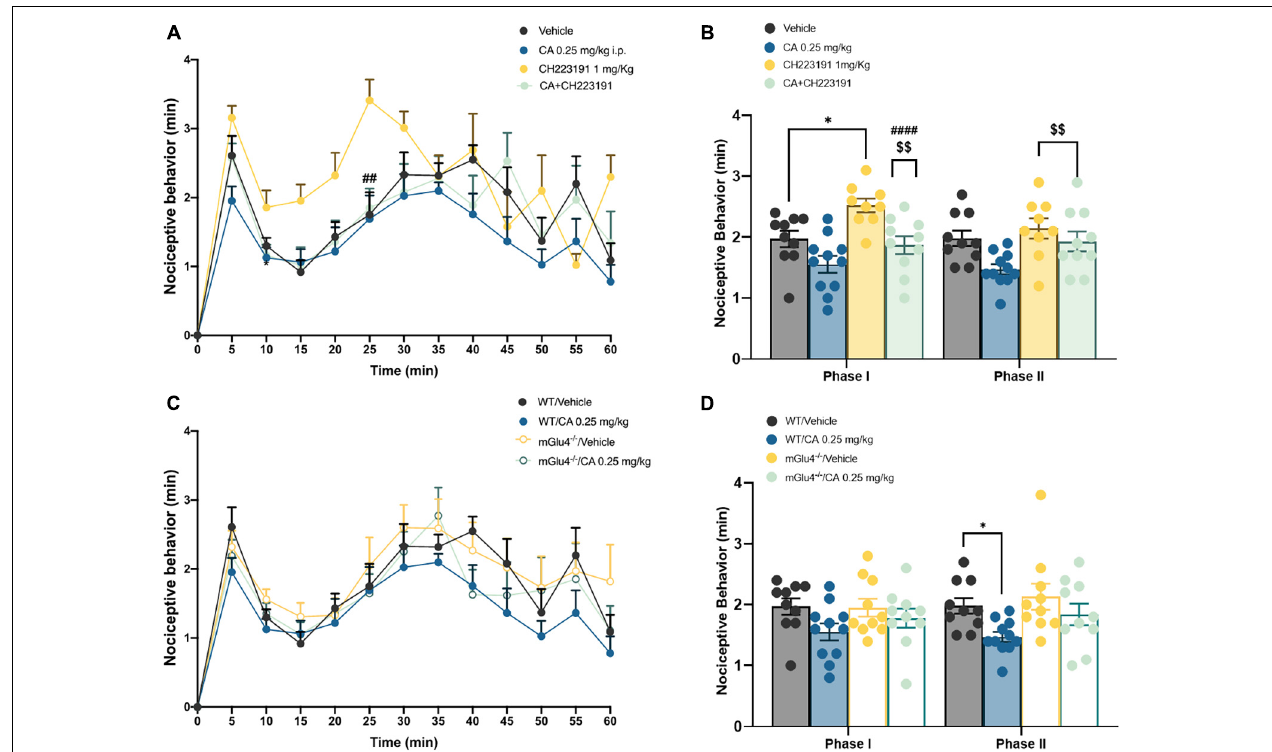
FIGURE 2 | Cinnabarinic acid-induced analgesia was mediated by the activation of mGlu4 receptor in WT and mGlu4 − / − mice. (A) Effect of cinnabarinic acid (0.25 mg/Kg) alone or in combination with CH223191 (1 mg/Kg) on formalin-induced pain behaviours, including lifting, flinching, and licking, observed for 60 min at 5 min intervals. (B) Total pain scores were classified as phase I (0–10 min) and phase II (30–60 min) in formalin-injected mice treated with vehicle or with cinnabarinic acid (0.25 mg/Kg) alone or in combination with CH223191 (1 mg/Kg). (C) Effect of cinnabarinic acid (0.25 mg/Kg) on formalin-induced pain behaviours, in WT and in mGlu4 − / − mice, observed for 60 min at 5 min intervals. (D) Total pain scores were classified as phase I (0–10 min) and phase II (30–60 min) in WT and in mGlu4 − / − mice formalin-injected mice treated with vehicle or with cinnabarinic acid (0.25 mg/Kg). Data are expressed as the means ± SEMs (two-way ANOVA for repeated measures with Tukey’s post-hoc test, * p < 0.05 vs. vehicle, $$ p < 0.01 vs. CH223191, and #### p < 0.0001 vs. CA, n =